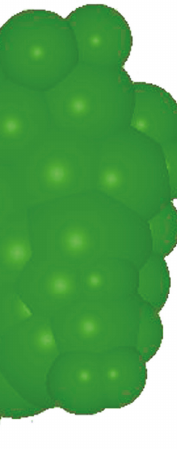
Figure 10: Iron ore particle modelling by the sphere clump method (thirty spheres).